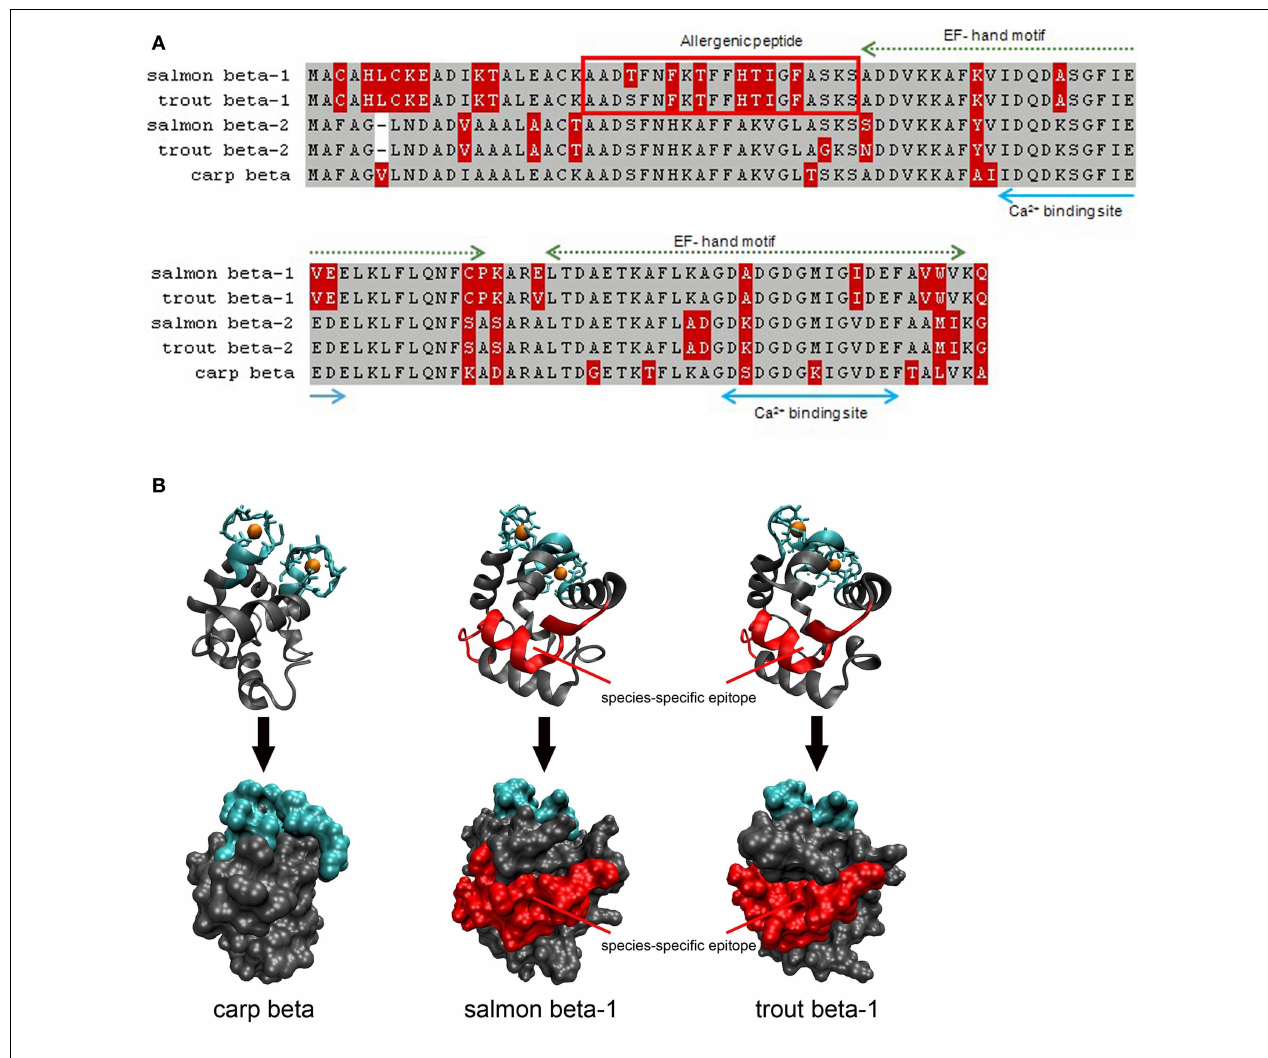
from a patient monosensitized to salmonid fishes. Gray, identical residues; red, variable residues. (B) Both Ribbon and surface models show that the allergenic peptide is localized on the surface of salmon and trout beta-1 parvalbumins. Blue, calcium-binding regions; red, IgE